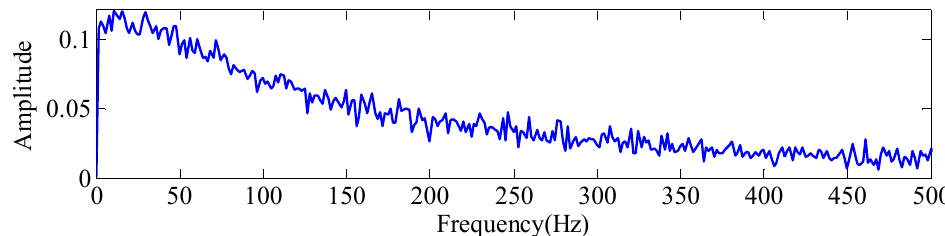
Figure 11. Signal segment with random value at 7 s to construct singular value decomposition of Hankel matrix to reduce envelope spectrum of noise signal.